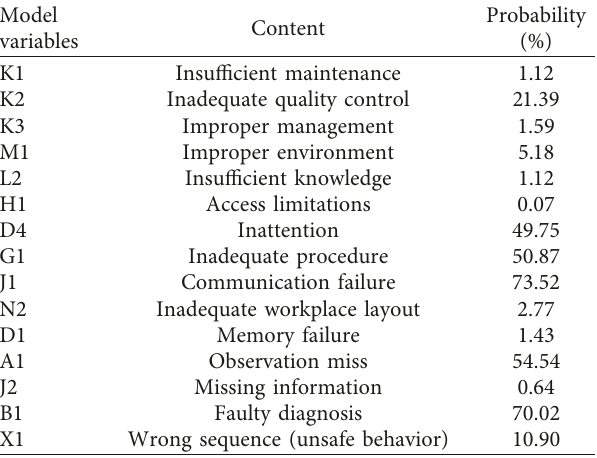
Table 2: Probabilityof nodesinthepresenceof